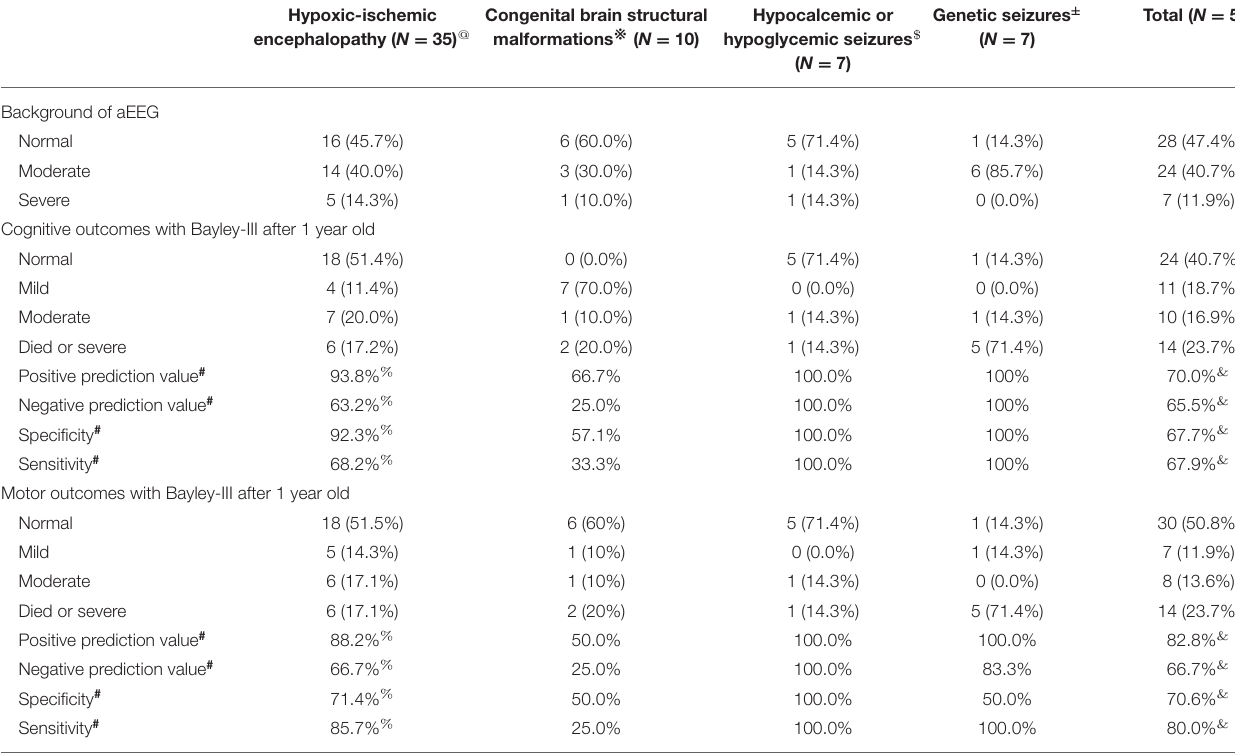
TABLE 2 | The Amplitude integrated electroencephalography (aEEG) and Electroencephalography (EEG) monitoring, and neurodevelopmental outcomes with Bayley-III evaluated at the age of at least older than 1 year in different